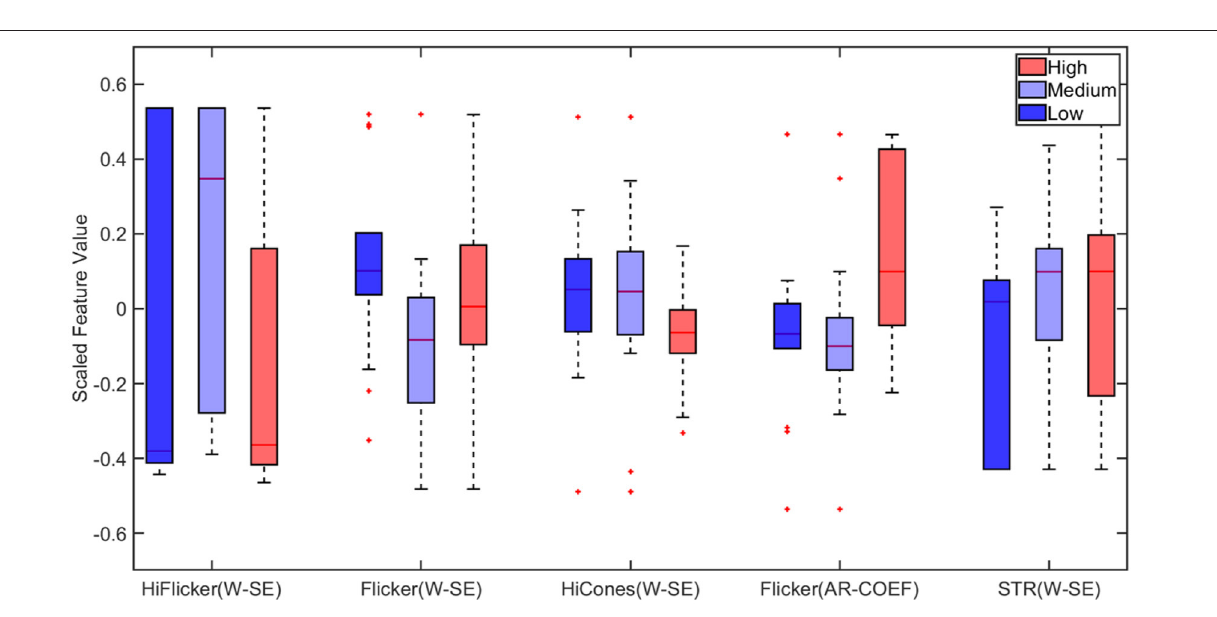
results using wavelet-based features are shown in Figure 10